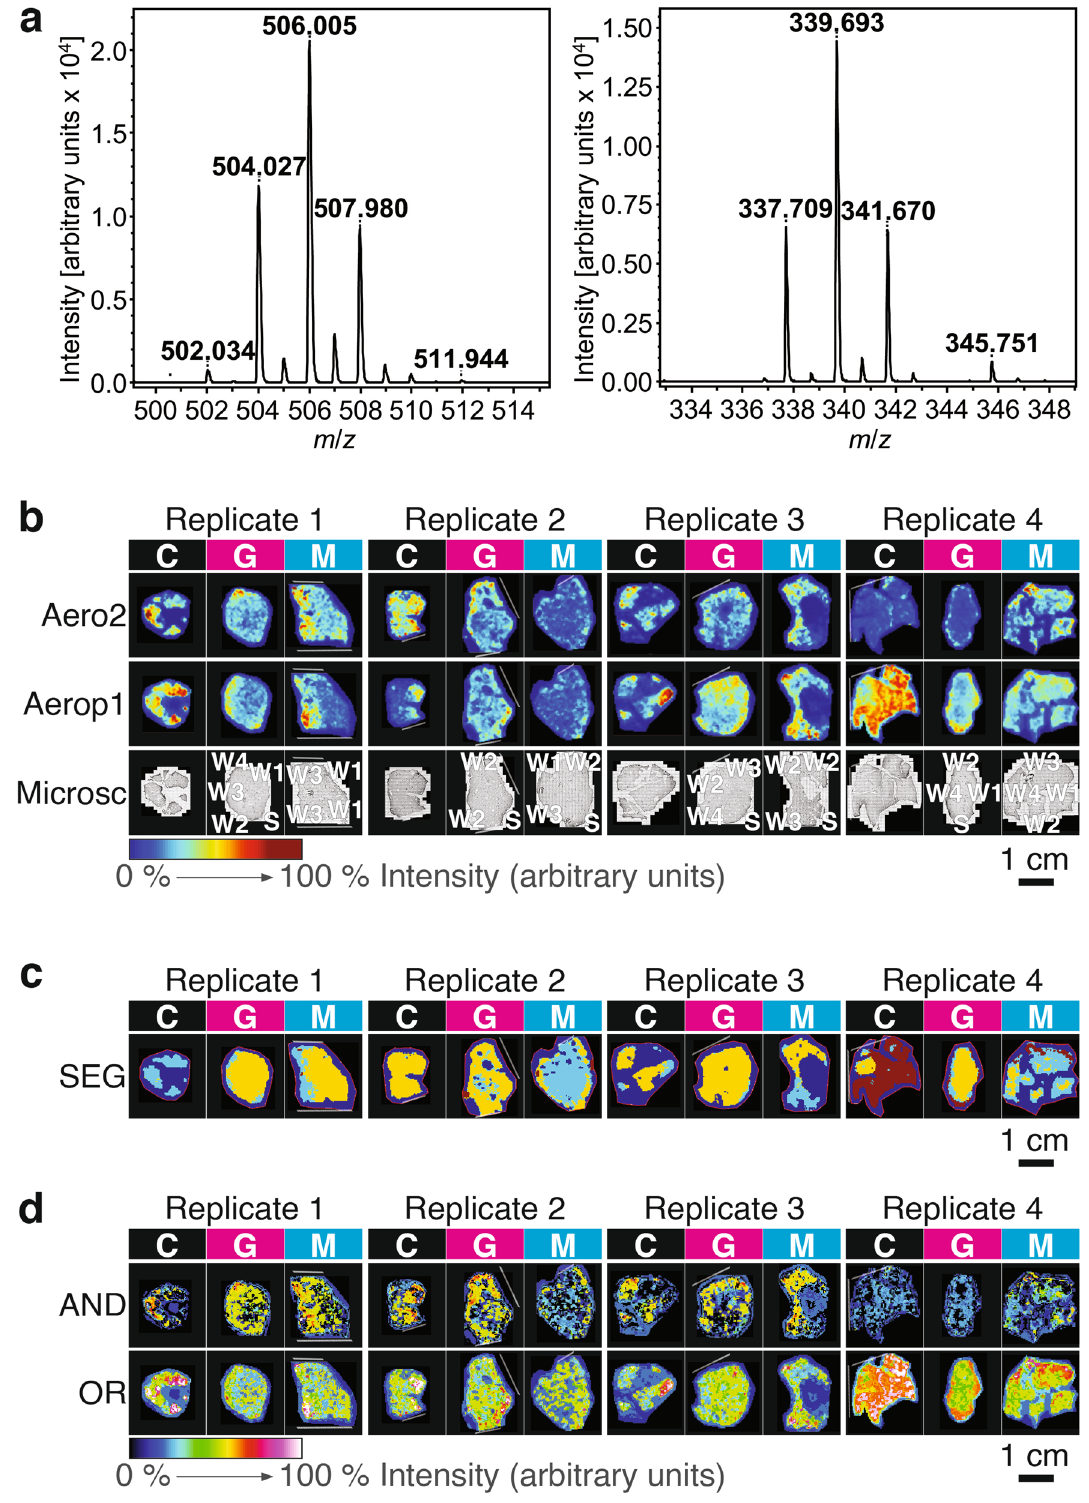
Figure 4. MALDI-imaging MS of sponges 1 day post-treatment. ( a ) The experimental isotopic patterns of aerophobin-2 (left panel) and aeroplysinin-1 (right panel) by MALDI-imaging MS. ( b ) The relative abundance of these compounds ( Aero2 aerophobin-2, Aerop1 aeroplysinin-1) in the three different treatments ( C control, G grazing, M mechanical damage) for each biological replicate (replicate; i.e., sponge individual). The corresponding microscopic images (Microsc) showing the location of the wounds are also shown, i.e. S surface (non-wounded); W1 the first evident wound; W2 the second evident wound, and so on. ( c ) Segmentation maps (SEG). Each cluster represents a chemical profile and is assigned a distinct colour that is comparable between treatments within each replicate. (d) Images of the co-localisation of aerophobin-2 and aeroplysinin-1 (AND), the distribution of at least one of these two compounds (OR, occurrence maps). The relative intensity from 0 to 100% is depicted in a colour scale with warmer colours representing relatively higher intensity and colder colours lower intensity of each compound. White-dotted line = broken or cut